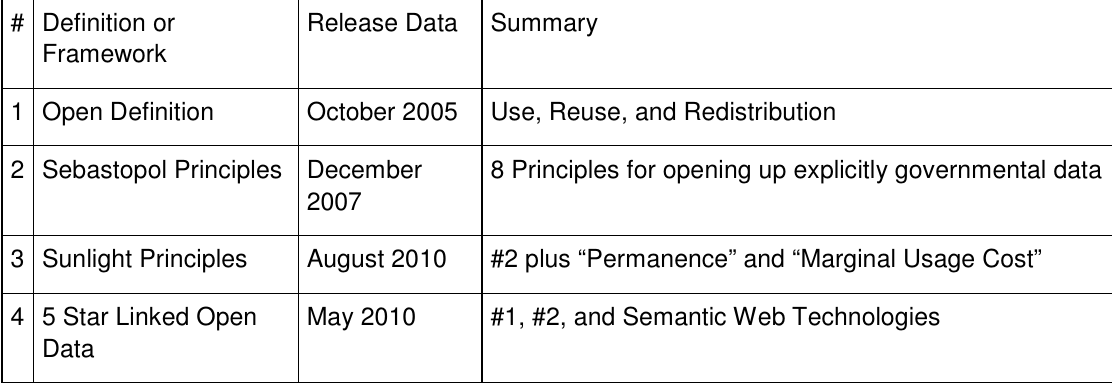
Table 1: Open Data Definitions and Frameworks Influencing the UK Ecosystem # Definition